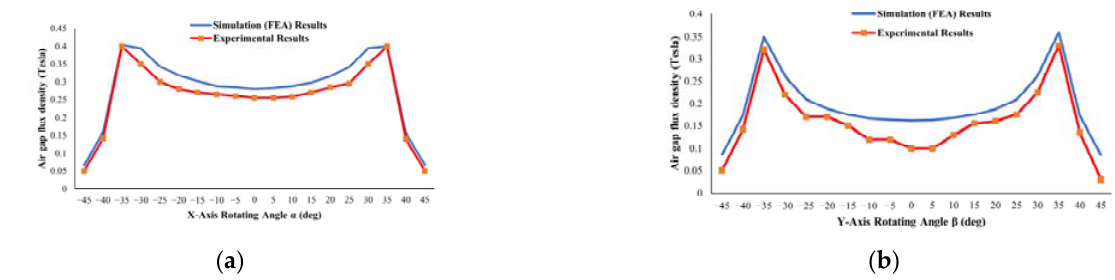
Figure 19. Measured and simulation results of the magnetic flux density in the air gap of the motor rotating around the X ‐ axis from α = 0° to α = ±45° ( a ) and rotating around the Y ‐ axis from β = 0° to β = ±45° ( b ).